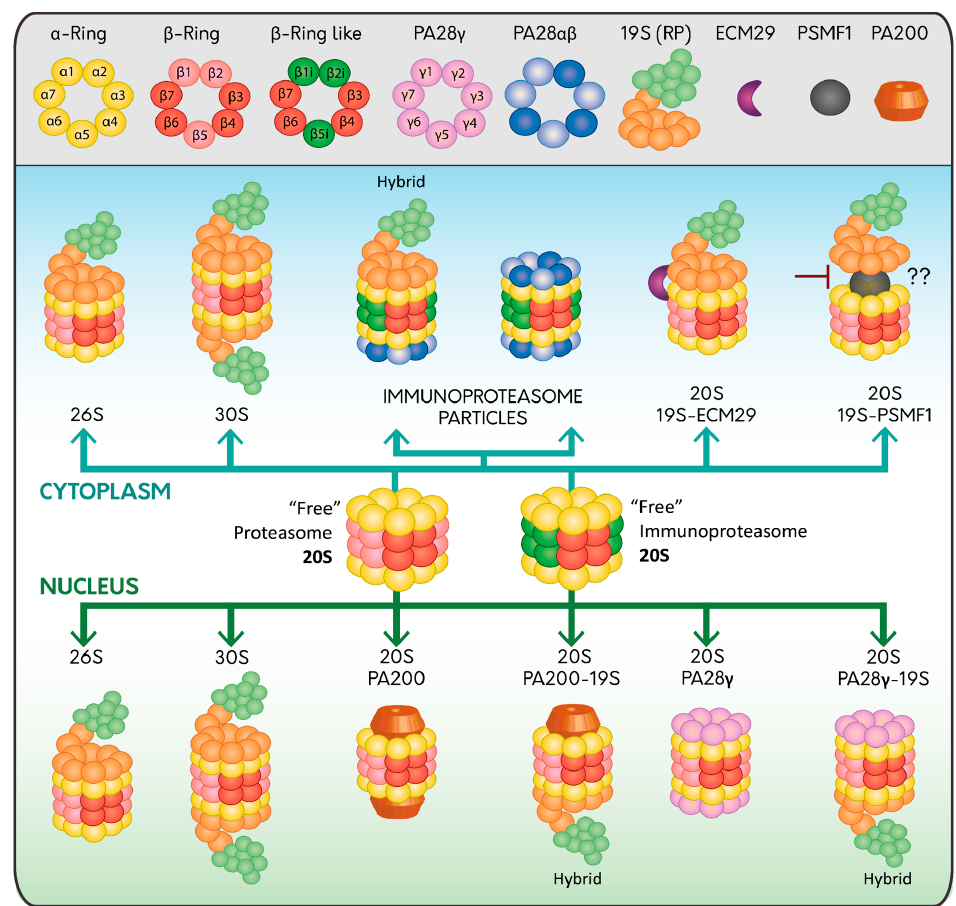
Figure 1. Proteasome assembly and its regulators. The constitutive 20S proteasome is assembled in α (Yellow) and β (Red) heptameric rings, constituting subunits β 1, β 2, β 5 of the catalytic core (Light Red); meanwhile the 20S immunoproteasome catalytic core has three inducible beta subunits named β 1i, β 2i and β 5i (Dark Green). Both types of proteasomes are found without regulators, indicated as “free” or can be associated with 19S RP (Light Orange and Light Green) either at one or both ends forming the 26S or 30S proteasome, respectively; or with the PA28 complexes either at one or both ends; PA28 αβ (Blue and Light Blue; cytoplasm) or PA28 γ (Pink; nucleus). Hybrid proteasome complexes (Hybrid) are also found when the catalytic core is simultaneously associated with 19S RP and another type of regulator (PA28 αβ , PA28 γ and PA200). Specific regulators in the cytoplasm are ECM29 (Purple) and PSMF1 (Grey), which can modify the assembly or activity of the proteasome; while in the nucleus the main proteasome regulator is PA200 (Dark